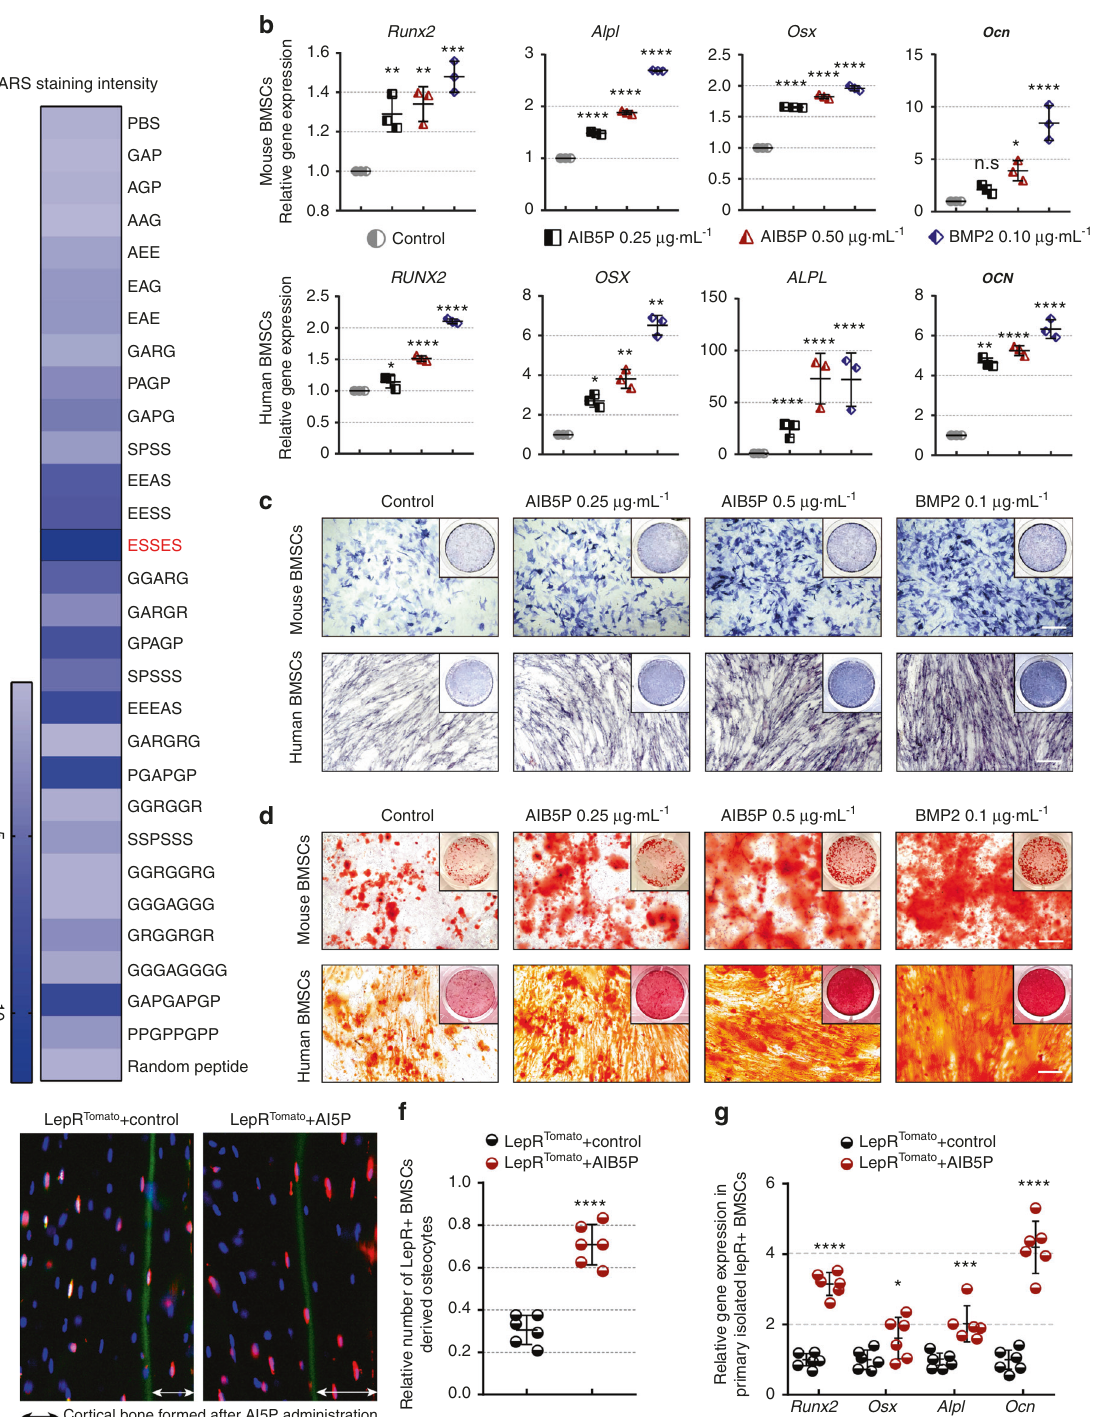
Fig. 3 AIB5P promotes osteogenic differentiation of BMSCs. a Color assignment of ARS staining for oligopeptide candidate output by our deep learning model. b qPCR analysis of Runx2 , Alpl , Osx , and Ocn expression levels in osteogenic-induced mBMSCs and hBMSCs after 1 week of AIB5P (0.25 μ g·mL − 1 , 0.5 μ g·mL − 1 ) or BMP2 treatment (0.1 μ g·mL − 1 ). n = 3. c Alkaline phosphatase (ALP) staining of osteogenic- induced mouse BMSCs and human BMSCs after one week of AIB5P (0.25 μ g·mL − 1 , 0.5 μ g·mL − 1 ) or BMP2 treatment (0.1 μ g·mL − 1 ). Bar, 100 μ m. d Alizarin red (ARS) staining of osteogenic-induced mouse BMSCs and human BMSCs after 1 week of AIB5P (0.25 μ g·mL − 1 , 0.5 μ g·mL − 1 ) or BMP2 treatment (0.1 μ g·mL − 1 ). Bar, 100 μ m. e Cell lineage tracing of the LepR + positive cells in newly formed cortical bone (representing LepR + -derived osteocytes). Calcein stained the bone deposition line when AIB5P administration started, and the double- headed arrow areas indicate red-positive osteocytes embedded within cortical bone. Bar, 100 μ m. f The normalized number of deposited LepR + -derived osteocytes after 2 weeks of AIB5P treatment at a dose of 100 μ g·kg − 1 every 3 days. n = 6. The red cells in the calcein- labeled medial cortical bone are osteocytes derived from LepR + cells. Bar, 25 μ m. g Runx2 , Osx , Alpl , and Ocn expression in LepR + BMSCs sorted by fl ow cytometry. n =